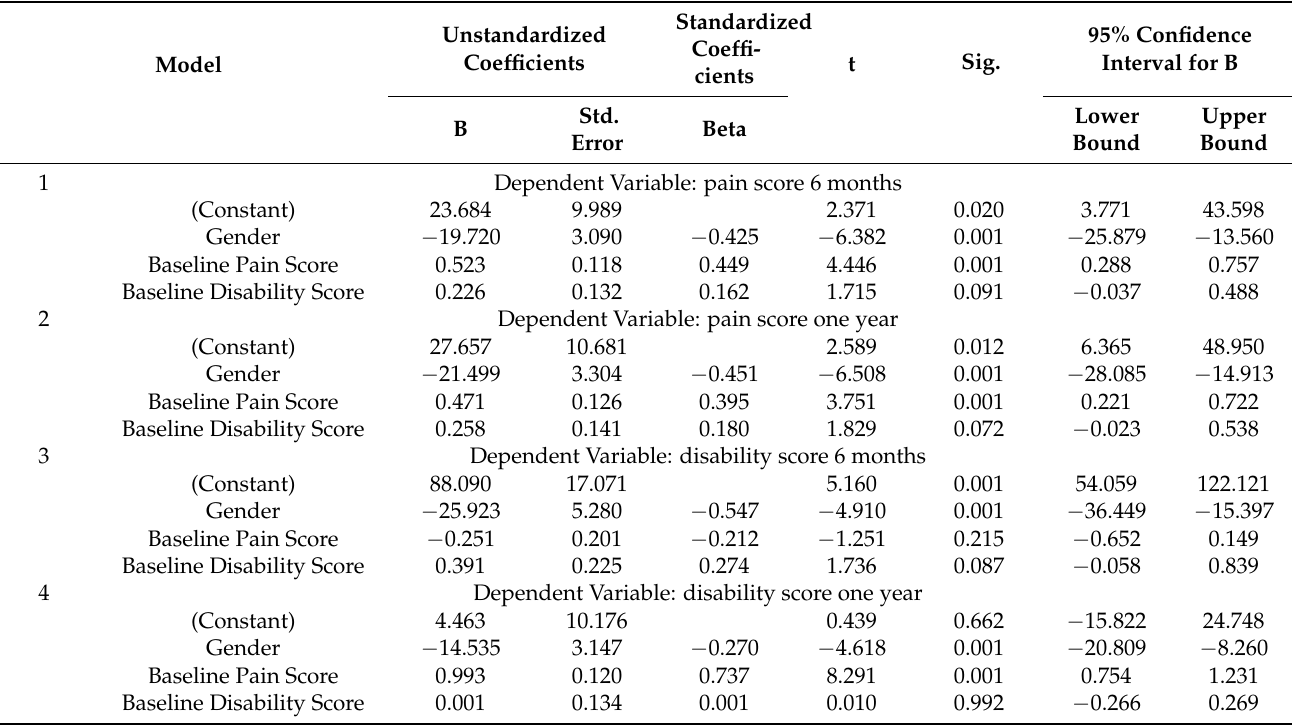
Table 4. Multiple linear regression analysis that considers gender, and the correlation between initial pain score and disability